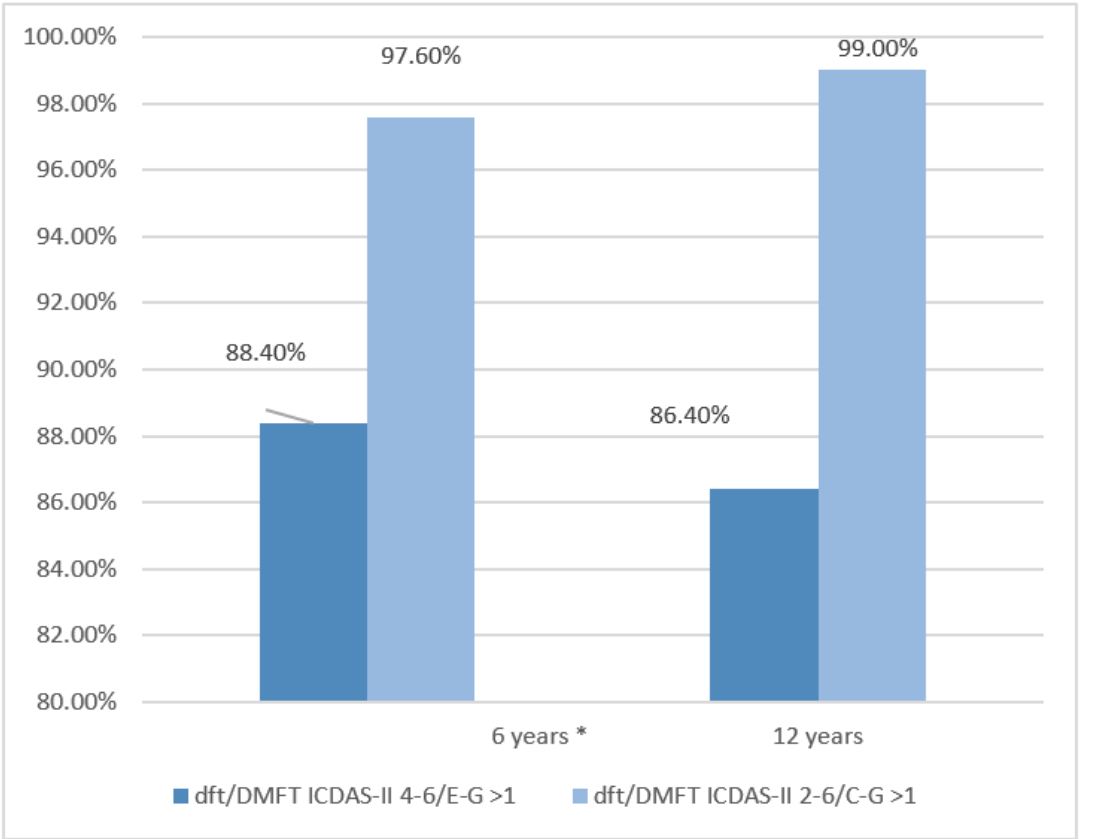
Figure 1. 6 years dft/ICDAS-II 4-6/E-G > 1: (IC = 84.9–91.4%) and dft/ICDAS-II 2-6/E-G > 1 (IC = 95.6–98.8%). 12 years DMFT/ICDAS-II 4-6/E-G > 1: (IC = 82.1%; 90.0%) and DMFT ICDAS-II 2-6/E-G > 1 (IC = 97.3–99.7%). * Primary dentition; International Caries Detection and Assessment System (ICDAS); decayed, missing, and filled teeth (DMFT). Confidence interval (CI); DMFT = rate of decayed, missing and filled teeth in permanent teeth; dft = rate of decayed and filled teeth in primary teeth.